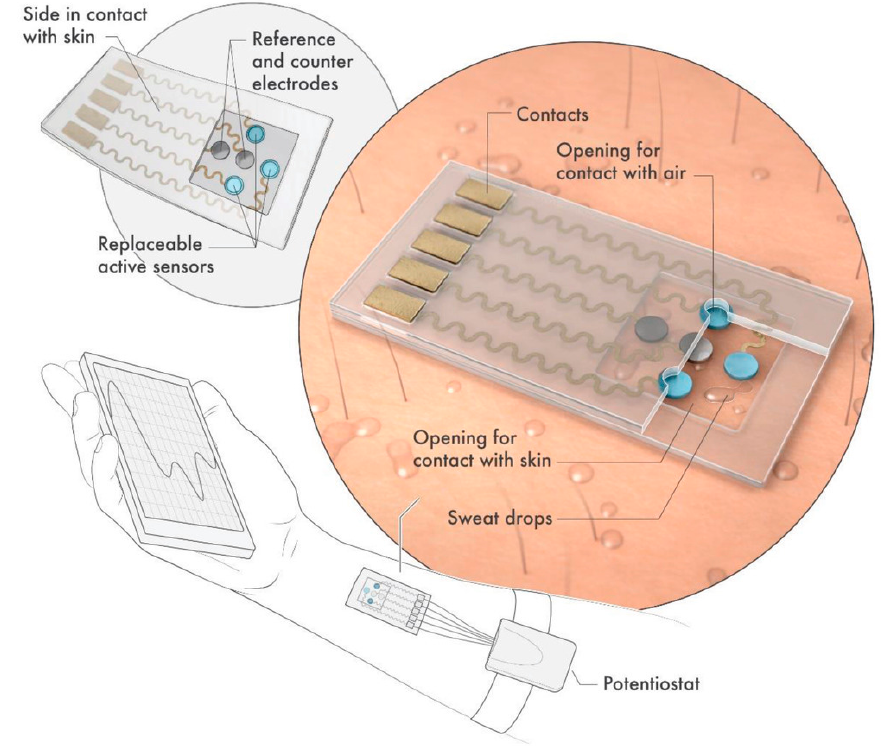
Figure 10. Schematic diagram of wearable sweat sensor (reprinted with permission from Figure10. reference [102]).